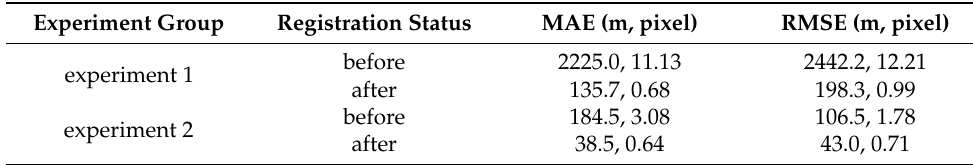
Table 1. Quantitative statistics of the planar residuals before and after registration using our proposed method in experiments 1 and 2.